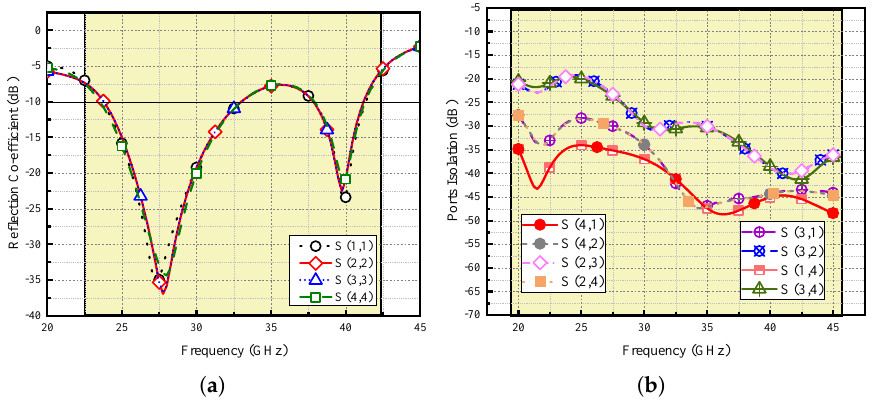
Figure 8. Olympeak MIMO antenna simulated s-parameters ( a ) reflection co-efficient ( b ) ports